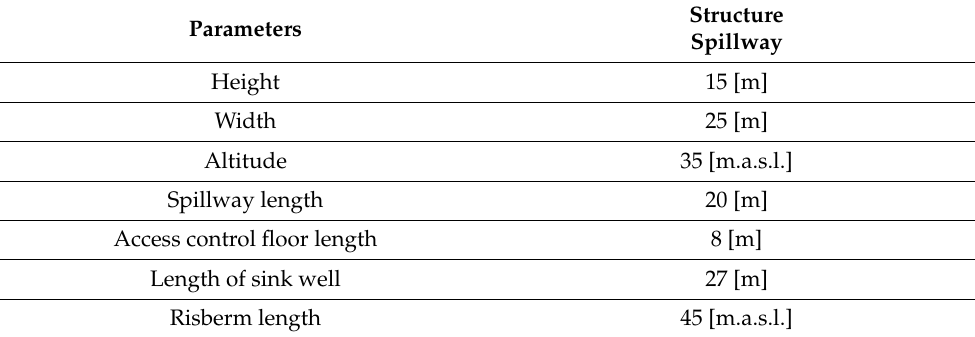
Table 11. Spillway